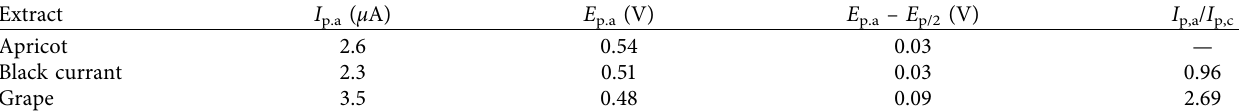
Table 6: The parameters extracted from the cyclic voltammetry curves to characterize the reducing ability of the extracts. Extract